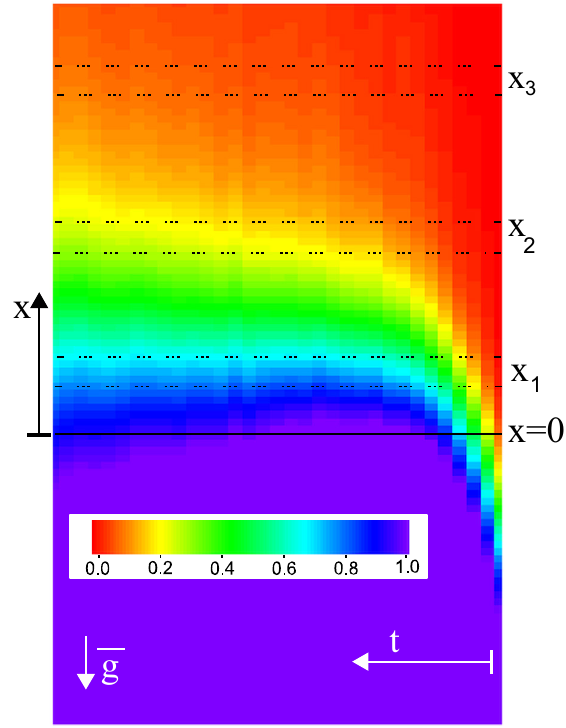
Figure 3. Spatiotemporal diagram of C’(x,t) for ϕ = 3% . The monitoring distances: x 1 = 1 mm, x 2 = 2.5 mm and x 3 = 4 mm are indicated.